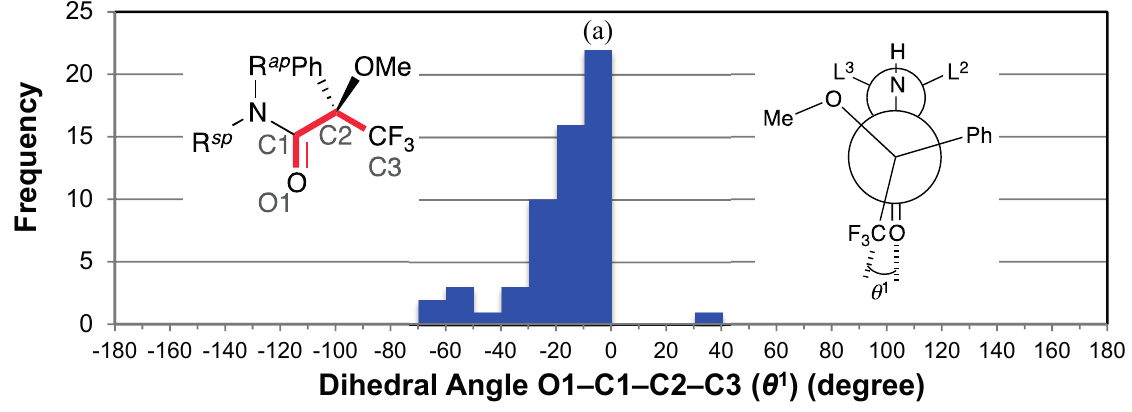
Figure 3. Histogram for dihedral angles between the amide carbonyl and trifluoromethyl groups of all MTPA amides. (a) The bar indicates the frequency of − 10 < θ 1 ≤ 0; and the same is true for the